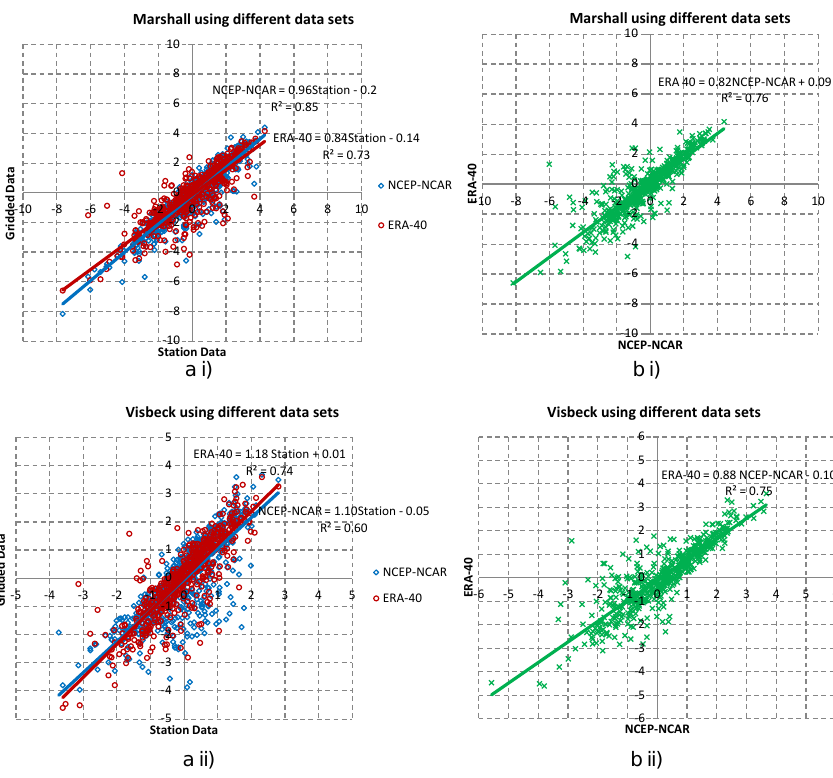
Fig. 3. (a) Station based monthly (i) Marshall and (ii) Visbeck SAM indices compared with their NCEP-NCAR and ERA-40 equivalents and (b) comparison between monthly (i) Marshall and (ii) Visbeck SAM indices recalculated using NCEP-NCAR and ERA-40 reanalysis